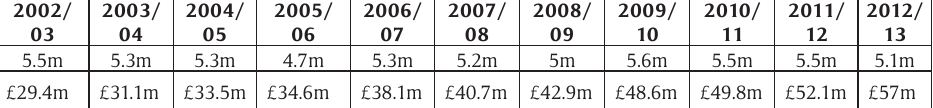
Note: The consultation document notes that Corporate services and office costs have been apportioned to the individual Table 3: Annual visitor numbers to staffed English Heritage sites (middle row) and earned income (bottom row), 2002/3–2012/13. 8